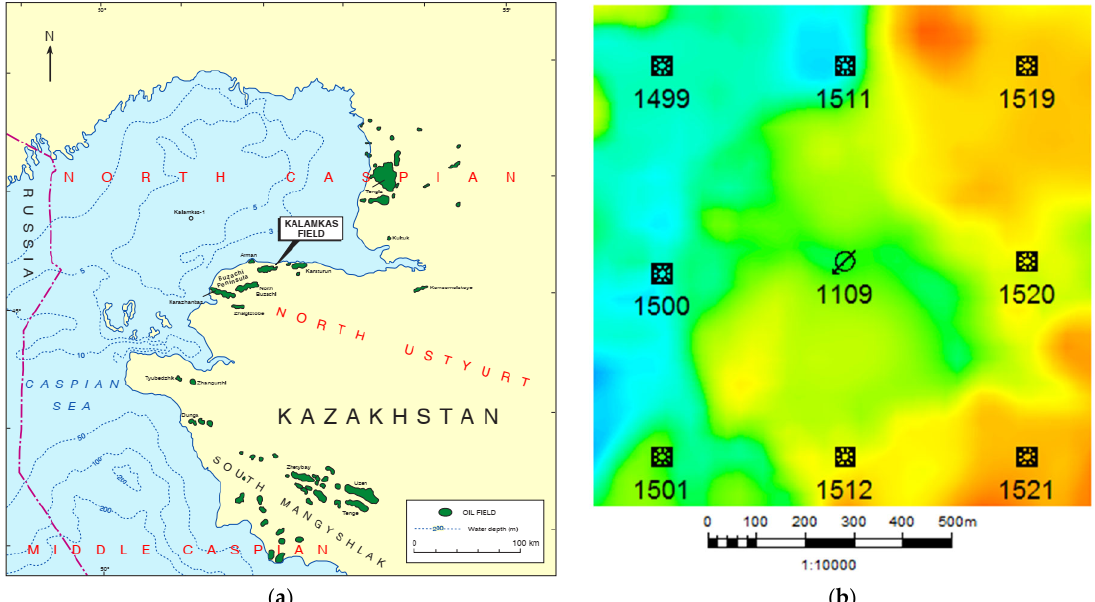
Figure 4. ( a ) Location of Kalamkas Field. Location of selected oil fields in western Kazakhstan. The Buzachi Peninsula is named due to the water surrounding the peninsula during the highstand period [39]. ( b ) Well pattern diagram of well group. The pattern diagram of the well group in application. It is a typical reverse nine ‐ point injection–production well pattern, with one injector in the center and eight producers around it.